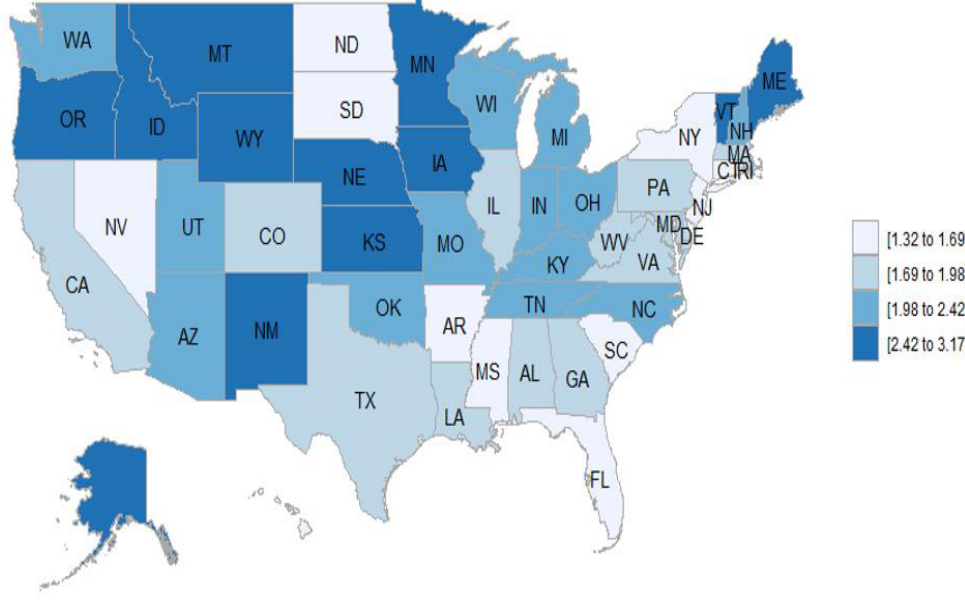
Figure 3. Age-adjusted mortality rates per million for vasculitis as the underlying cause of death, by state, from 1999 to 2019.